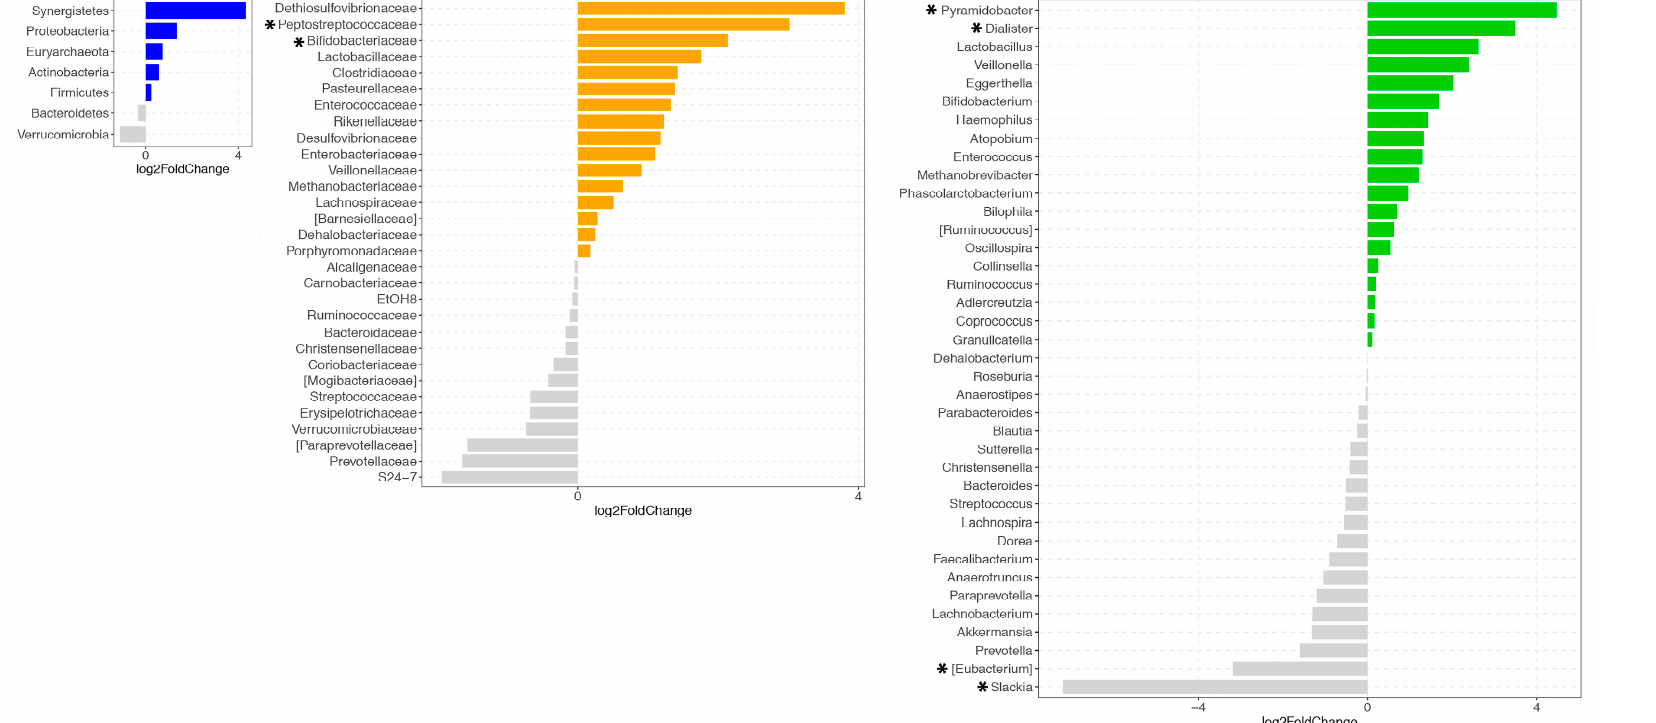
Figure 2. Comparison of gut microbiota relative abundance at the phylum (left panel, blue), family (middle panel, orange), and genus (right panel, green) levels between participants with PF&S and nonPF&S controls. Comparisons with a negative log 2 fold change (log2FC) are represented in grey. Only comparisons with a log2FC higher or lower than ± 1.5 and an adjusted p value < 0.05 are considered significant (*).